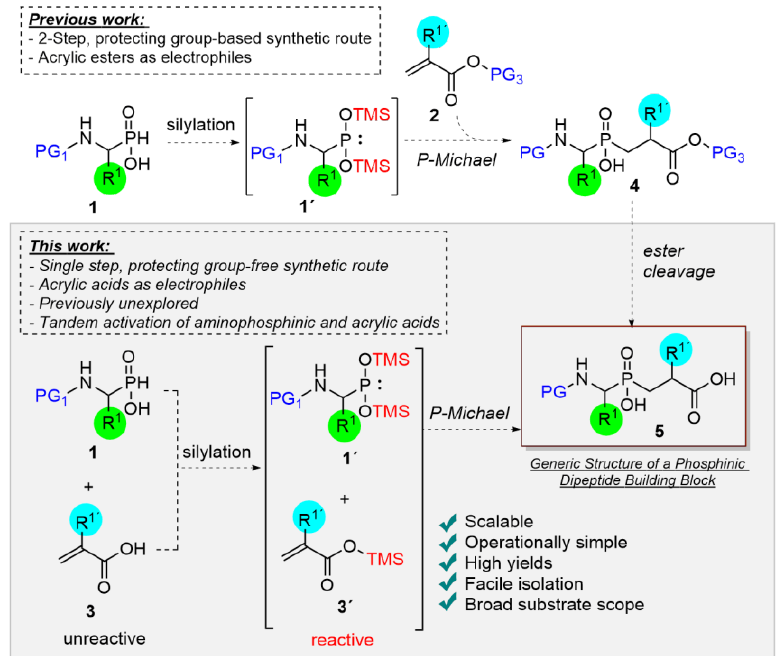
Scheme 2. Schematic representation of previously described protocol towards the synthesis of building blocks of type 5 and proposed protocol in this